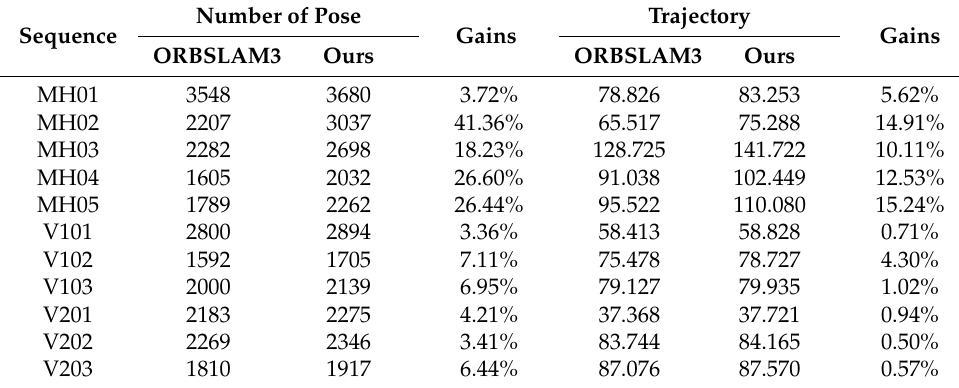
Table 1. Comparison of ORB-SLAM3 and proposed algorithm. It includes the comparison and improvement of the number of the Pose and the trajectory length (unit in meters). The Pose is estimated by the SLAM system according to the video sequence, and its number is the same as the number of the Pose in the trajectory